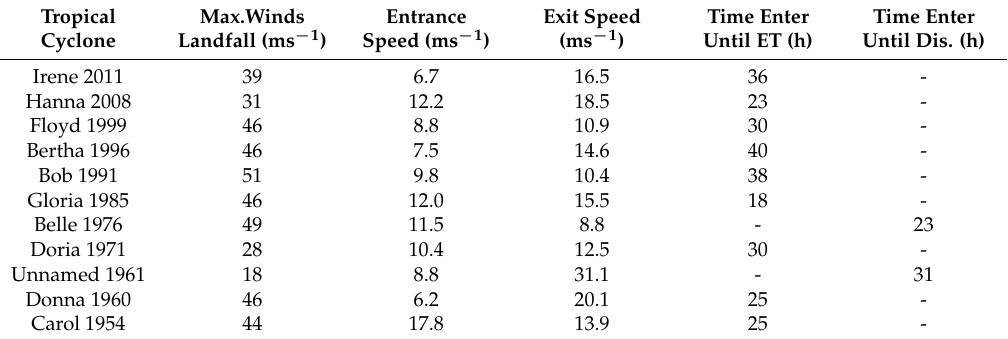
Table 1. Maximum sustained wind speed when TC made landfall, storm translational speed upon entering and exiting the study region, number of hours from entrance until completing an extratropical transition, and the number of hours from entrance until dissipating for TCs that did not complete an ET. Tropical